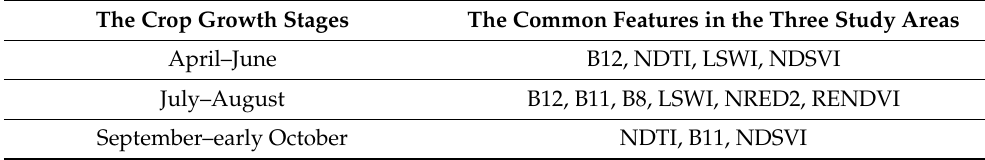
Table 6. The key common features in different stages of the three study